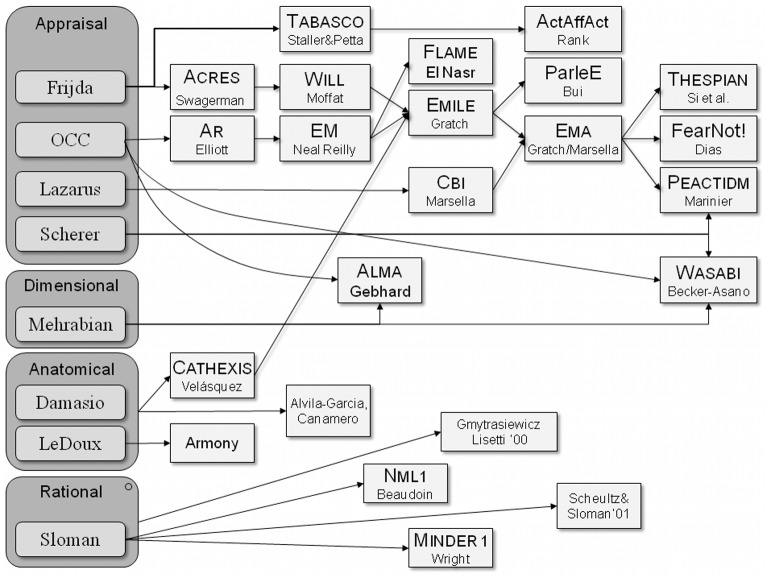
Emotional models in artificial intelligence (Scherer et al., 2010).